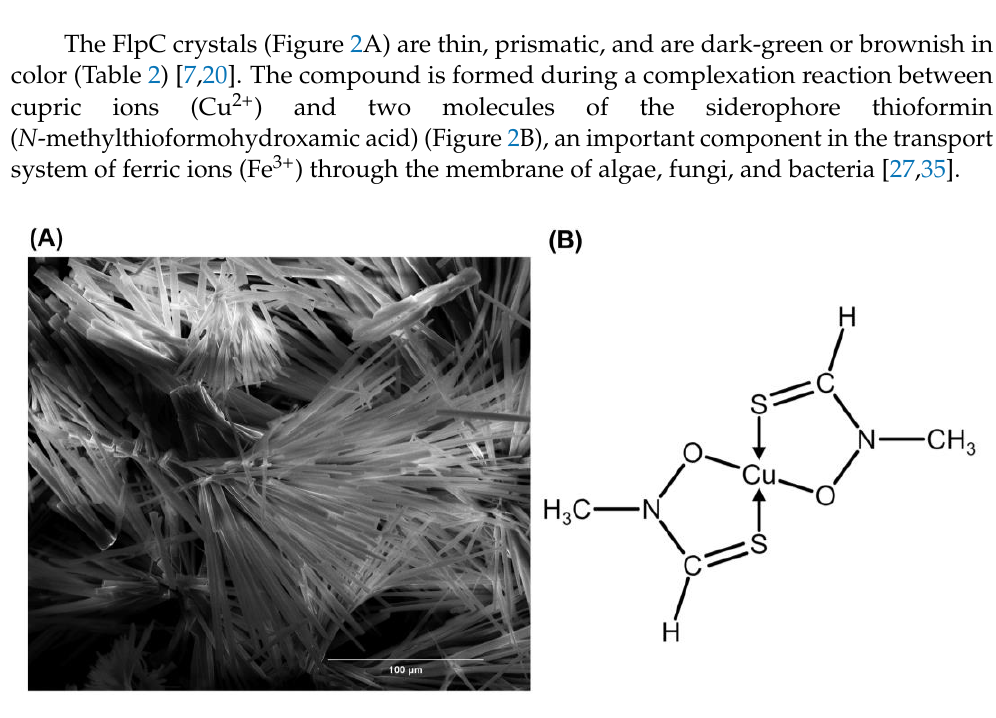
Figure 2. Fluopsin C. ( A ) scanning electron microscopy micrography of Fluopsin C crystals; ( B ) molecular structure of Fluopsin C (C 4 H 8 N 2 O 2 S 2 Cu), a coordination compound formed by two molecules of the thiohydroxamic siderophore thioformin (C 2 H 5 NOS) bonded with one central metal ion of copper. Table 2. Main organometallic complexes in the Fluopsin group (thioformin complexes).